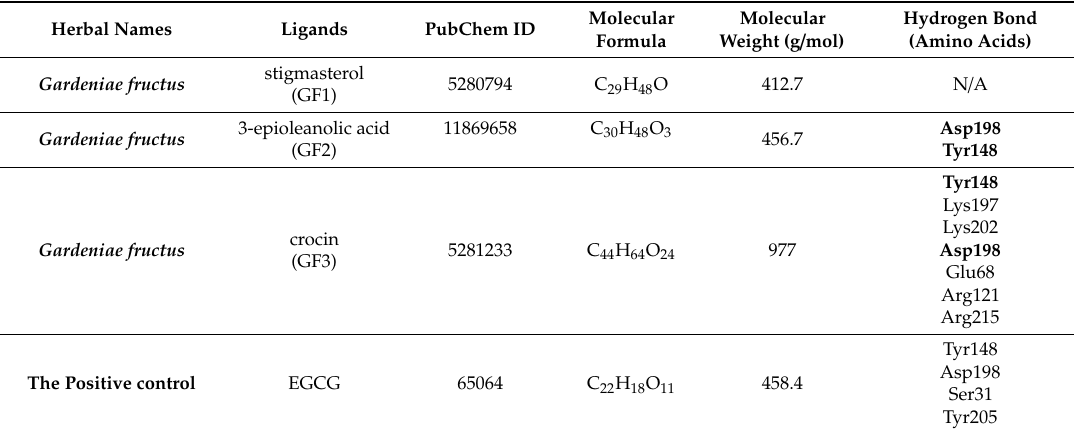
Figure 3. 3D ribbon diagram showing the binding site of predicted leading compounds stigmasterol (blue), 3-epioleanolic acid (pink), crocin (orange) and the positive control EGCG (lilac), on the GLP-1 receptor (PDBID: 5NX2). Table 2. Top 3 ligands predicted from Gardeniae fructus with the strongest binding a ffi nity and their interactions with